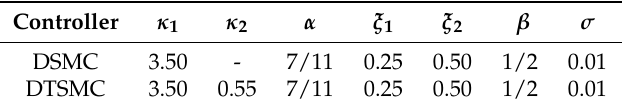
Figure 10. The tracking results under 0.1 Hz input signal. ( a ) Displacement output. ( b ) Tracking error. ( c ) Desired displacement versus actual displacement of the DSMC. ( d ) Desired displacement versus actual displacement of the DTSMC. Table 5. The control parameters of different